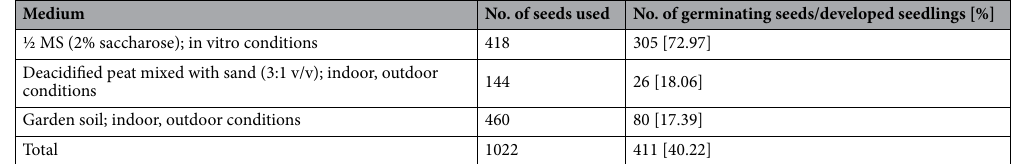
Table 1. Seed germination of Pulsatilla patens on different substrates. MS—Murashige & Skoog 38 medium.